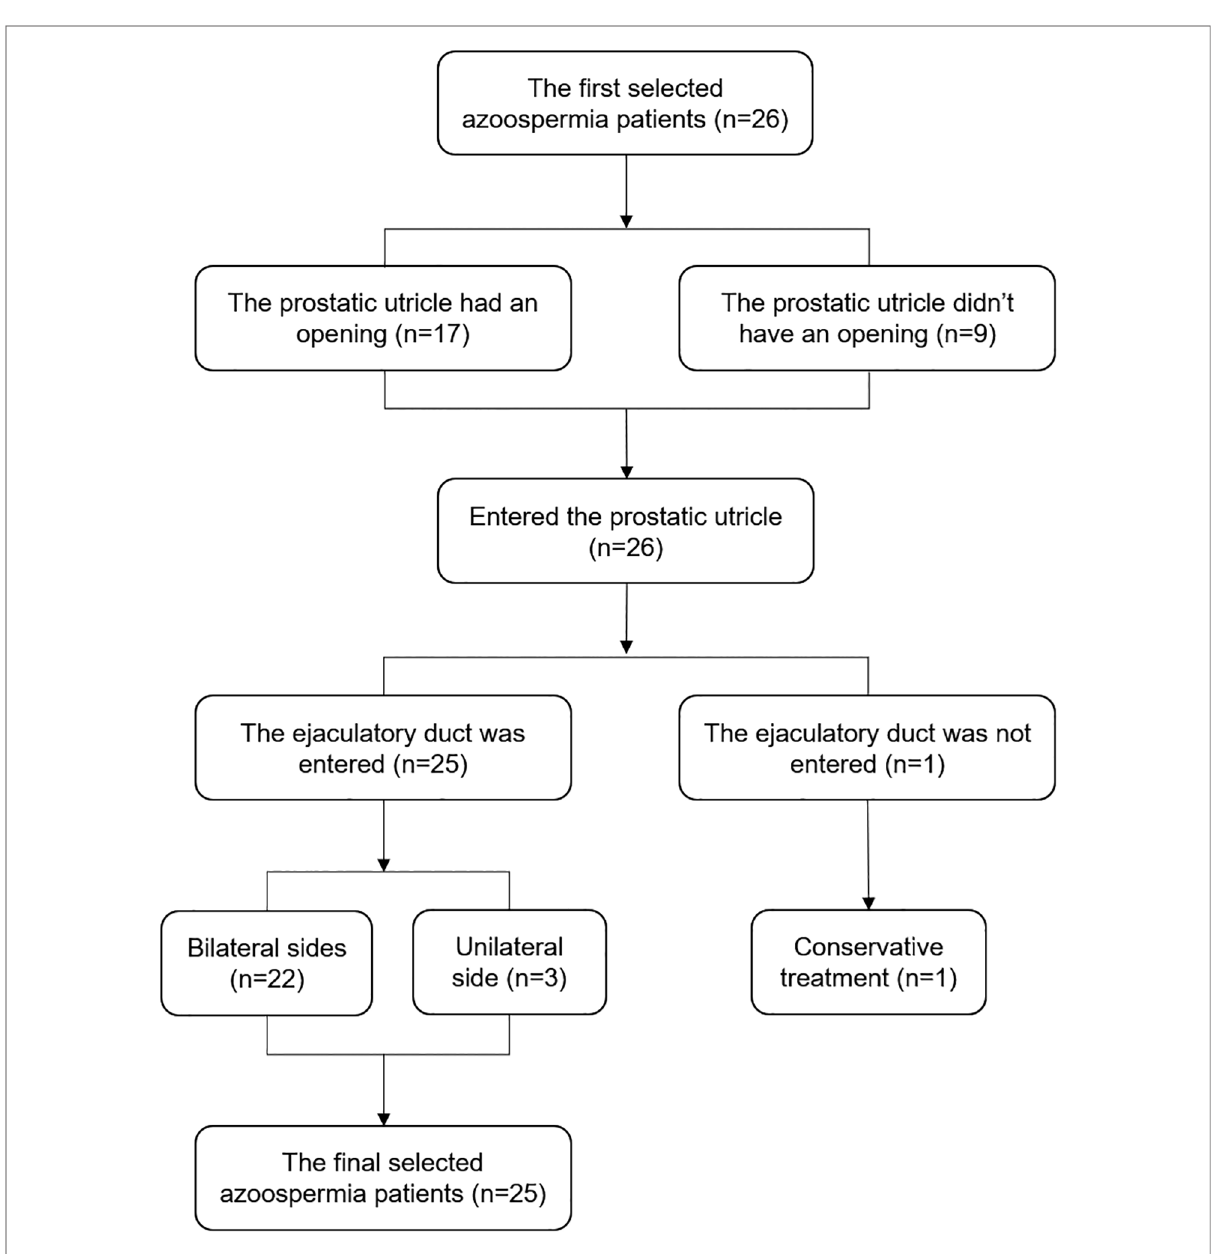
FIGURE 2 Flowchart of surgical